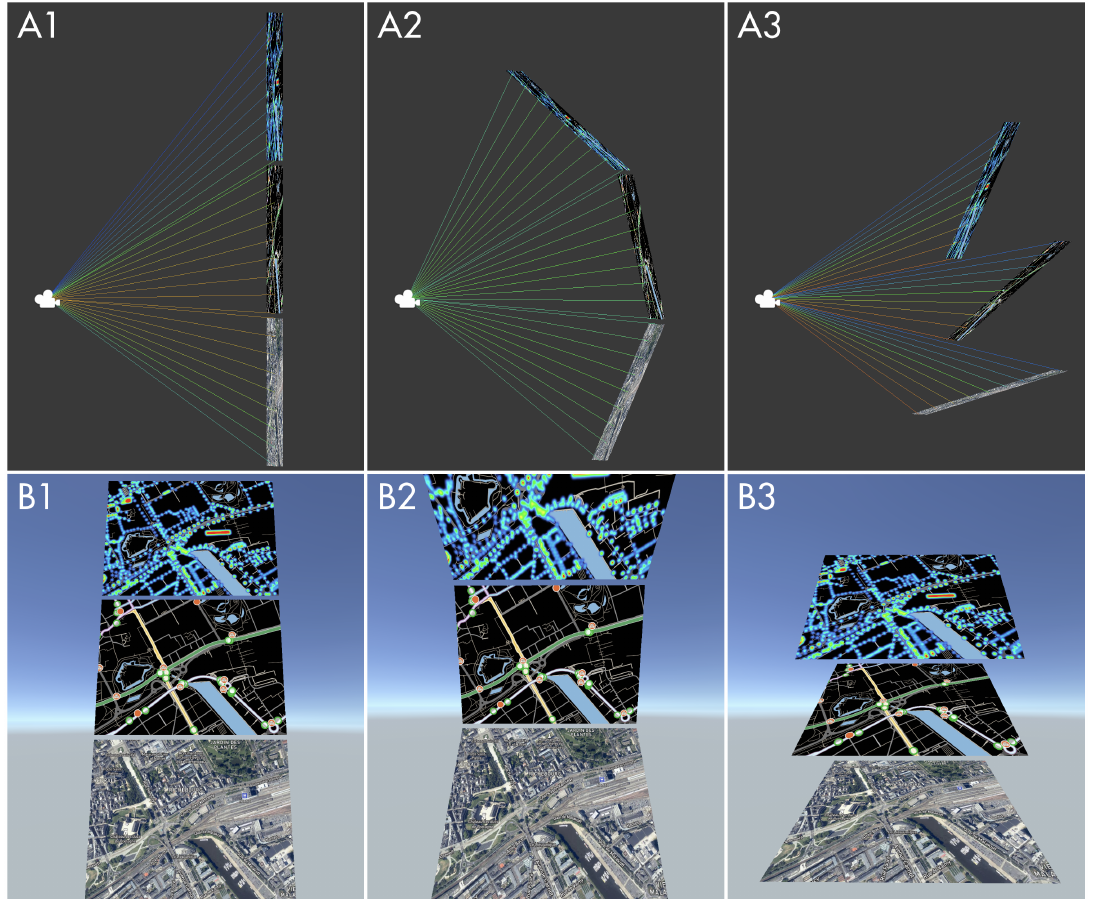
Figure A1. ( A )bove ( A1 – A3 ): Isometric views from the side of a flat configuration of three layers ( A1 ), a stack with each layer perpendicular to the viewline ( A2 ), and a stack with each layer tilted at 40 degrees ( A3 ). Colored lines between illustrate differences in distance between camera and equidistant points on the layers: green is the average distance, a shift to red signifies less distance, a shift to blue more. ( B )elow ( B1 – B3 ): the corresponding camera views of the same number in ( A ), with equal fields of view (tilted up in ( B1 )). All layers equal in